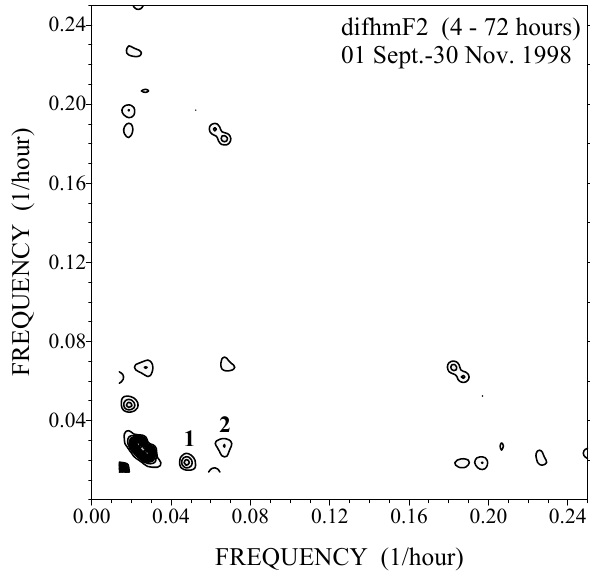
Fig. 14. The contour plot of the magnitude square bispectrum cal- culated from the residual of the hm F2 data in the period interval